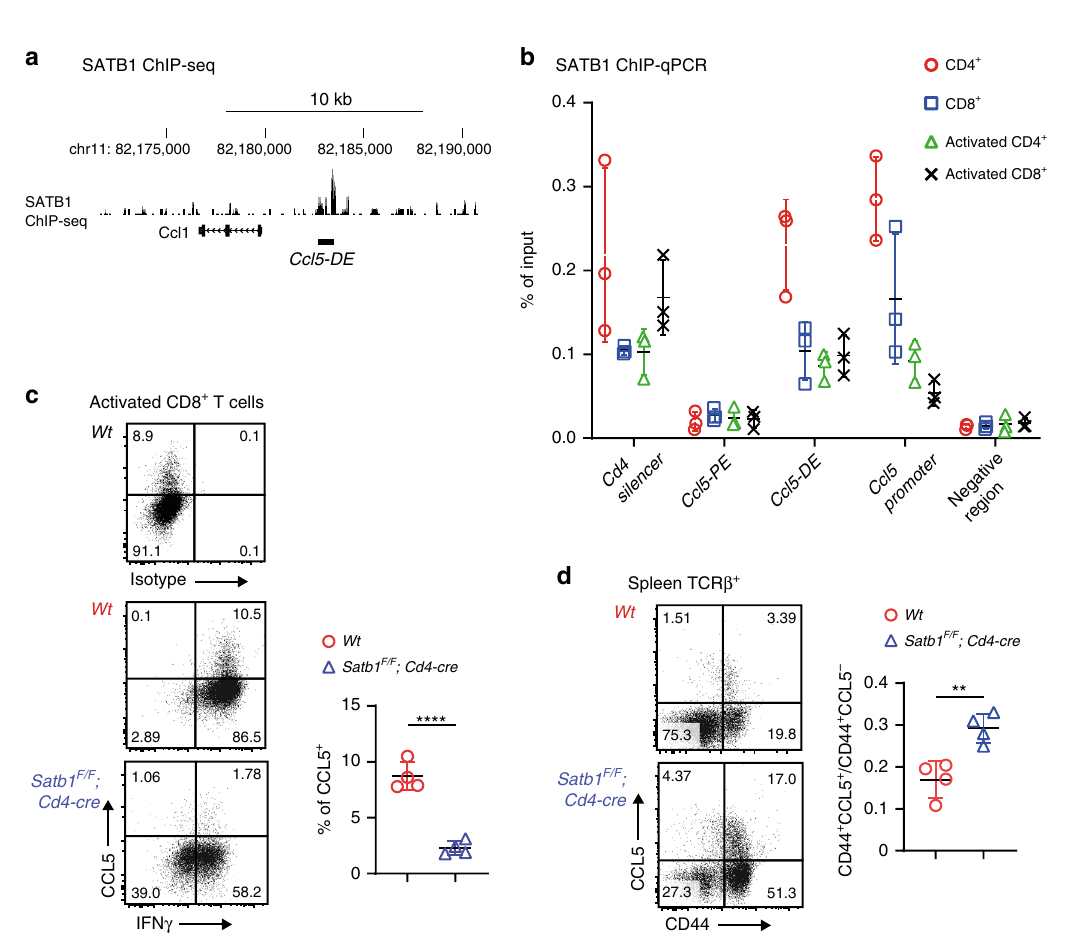
Fig. 5 Ccl5 distal enhancer ( DE ) regulates Ccl5 induction in activated T cells by the help of SATB1. a An SATB1 ChIP-seq track in peripheral CD4 + T cells using GSE90635 around Ccl5-DE . b Summary of three SATB1 ChIP-qPCRs using spleen and activated CD4 + and CD8 + T cells from three mice per group. The Cd4 silencer region was included as a positive control for SATB1 binding. Error bars indicate Mean± SD and each dot represents a mouse examined over at least two independent experiments. c Representative dot plots showing CCL5 and INF γ expression in control and SATB1-de fi cient activated CD8 + T cells at 5 days after in vitro simulation with a summary graph. Error bars indicate Mean± SD and each dot represents a mouse examined over at least two independent experiments. Statistical signi fi cance is measured via unpaired two-tailed Student ’ s t tests and is presented as follows: **** p < 0.0001. d Dot plots showing CCL5 expression in TCR β + T cells of Wt and Satb1 F/F ;Cd4-cre mice. One representative plot of multiple independent experiments. Numbers in the dot plots indicate the percentage of cells in each quadrant. Error bars indicate Mean± SD and each dot represents a mouse. Statistical signi fi cance is measured via unpaired two-tailed Student ’ s t tests and is presented as follows: **** p < 0.0001, ** p < 0.01. Source data are provided as a Source Data fi